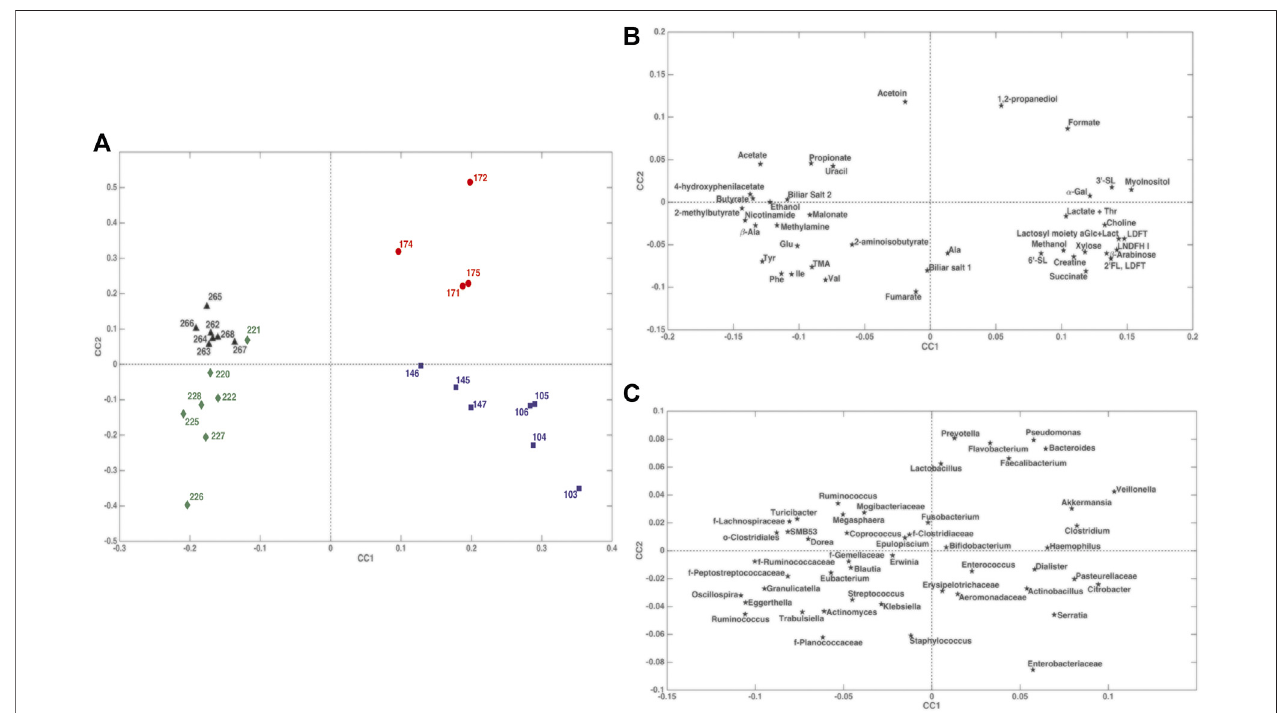
FIGURE8| ComDimscoresandloadingsplotsoftheindividualcomponentsbuiltfrommetabolomicsandtaxonomicalmetagenomicsdata.Panel (A) :scoresplot; panel (B) : loadings plot for the metabolomic data set; panel (C) : loadings plot for the metagenomic data